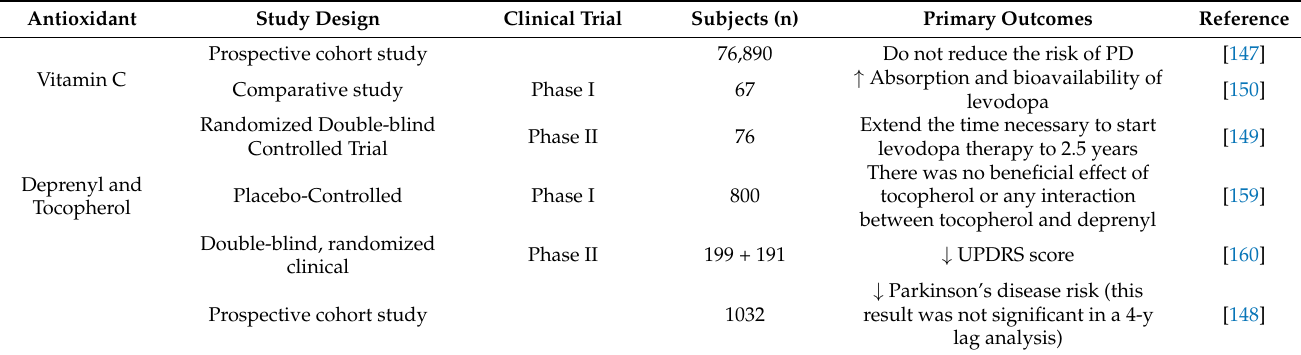
Table 4. Summary of vitamins antioxidant effects on PD clinical